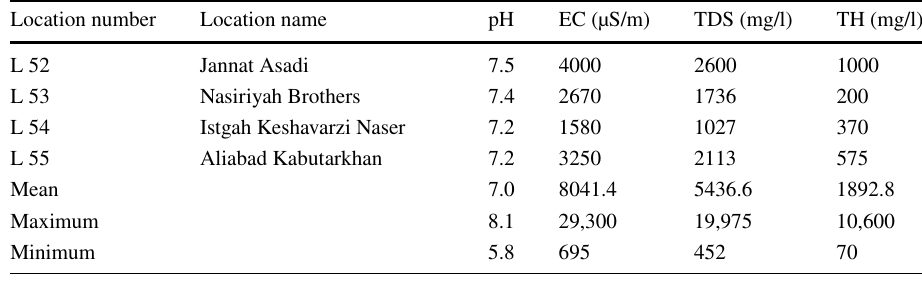
Fig. 6 Spatial distribution of a pH; b electrical conductivity (EC); c total dissolved solids (TDS) and d total hardness (TH) in Rafsanjan